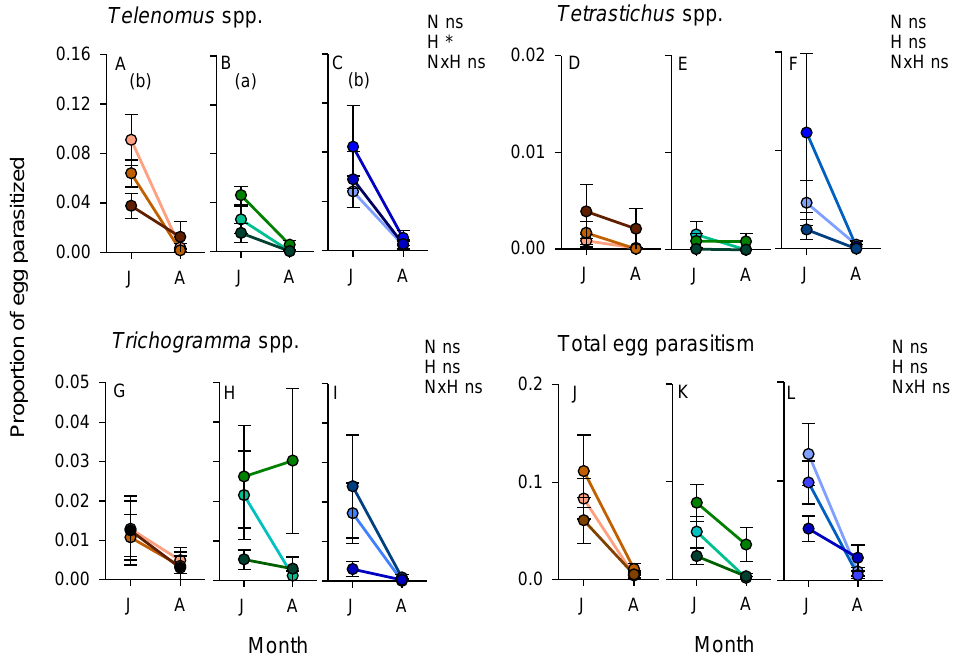
Figure 9. Parasitism of stemborer eggs on rice plants adjacent to clear bunds (brown lines: A, D, G, J), weedy bunds (green lines: B, E, H, K), and sesame bunds (blue lines: C, F, I, L) during July (J) and August (A) of the 2011 wet season crop. Graphs indicate parasitism by Telenomus spp. ( A – C ), Tetrastichus spp. ( D – F ), and Trichogramma spp. ( G – I ) as well as the total parasitism ( J – L ). Plots were planted with IR66 and received one of three nitrogen-fertilizer treatments (indicated by color intensity of points, N1 = light, N2 = medium, N3 = dark). Standard errors are indicated ( n = 8). GLM results for the effects of nitrogen (N), habitat type (H) and their interactions (N × H) are indicated for each parasitoid group; ns = p > 0.05, * = p < 0.05. Lowercase letters indicate homogenous habitat groups.